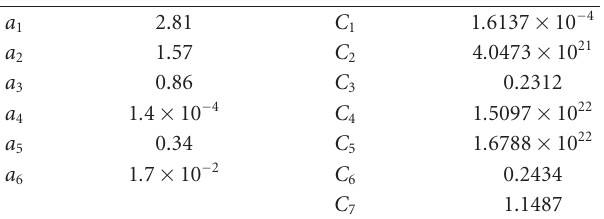
Table 2: Constants in Time and Laplace S Domain for Creep (6) and (7).